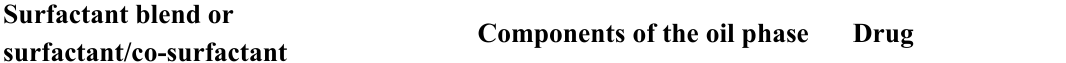
Table 2. Examples of microemulsion composition and incorporated drugs used as transdermal delivery